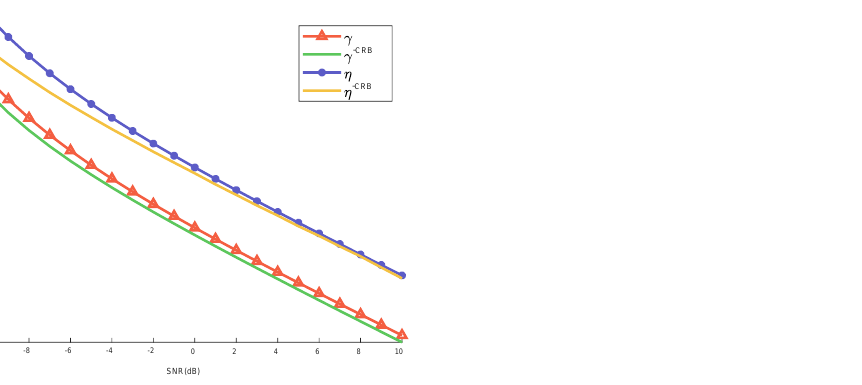
Figure 6. RMSE of elevation with respect to the snapshot number when SNR = 20 dB: ( a ) θ d = 1 ◦ ; ( b ) θ d = 2 ◦